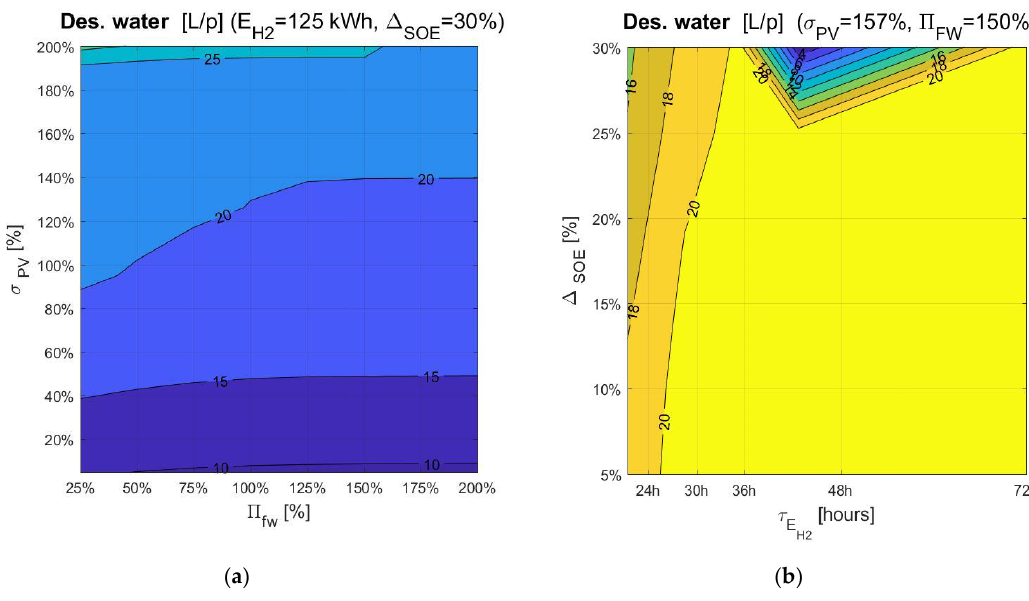
Figure 10. Annual desalinated water production per-capita. Sensitivity analysis about: ( a ) σ PV and Π FW , for constant value of 𝜏 𝐸